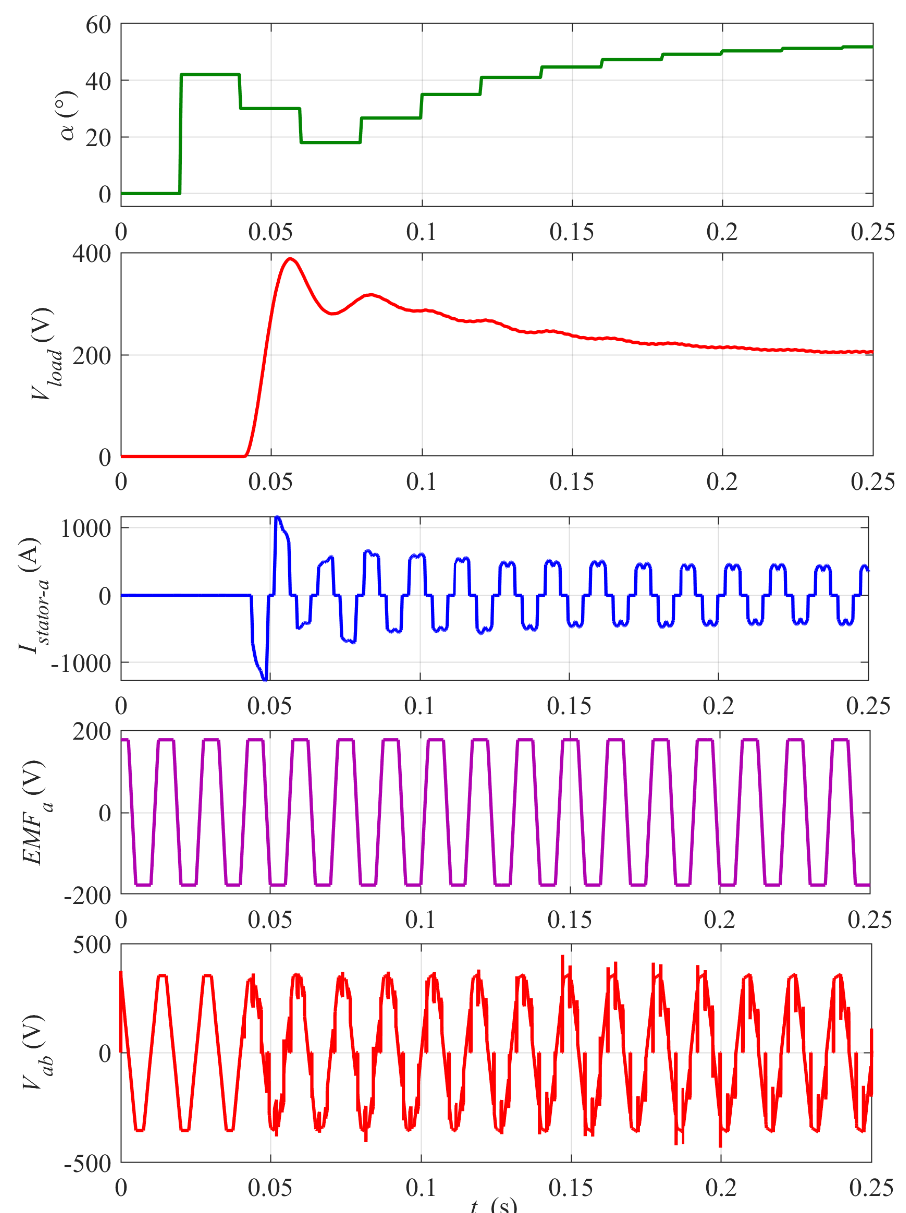
Figure 9. Start-up of the rectifier. Zoomed-in view of waveforms from Figure 8. The digital control Figure 9. Start- up of the rectifier. Zoom ed- in view of waveforms from Figure 8. The digital control update period T sc = 20 ms. Note two -control- period (40 ms) delay of the start of the rectifier pulsing update period T sc = 20 ms. Note two-control-period (40 ms) delay of the start of the rectifier pulsing and the stator current. and the stator